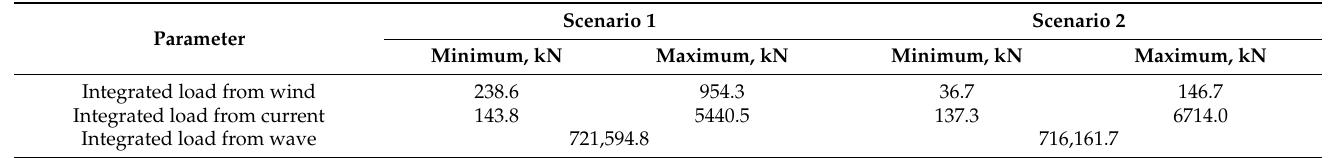
Figure 8. The distribution of the linear load from the waves on the platform depending on the parameter χ : ( a ) Scenario 1; ( b ) Scenario 2. Table 11. Integrated loads on platforms according to Scenario 1 and Scenario 2.